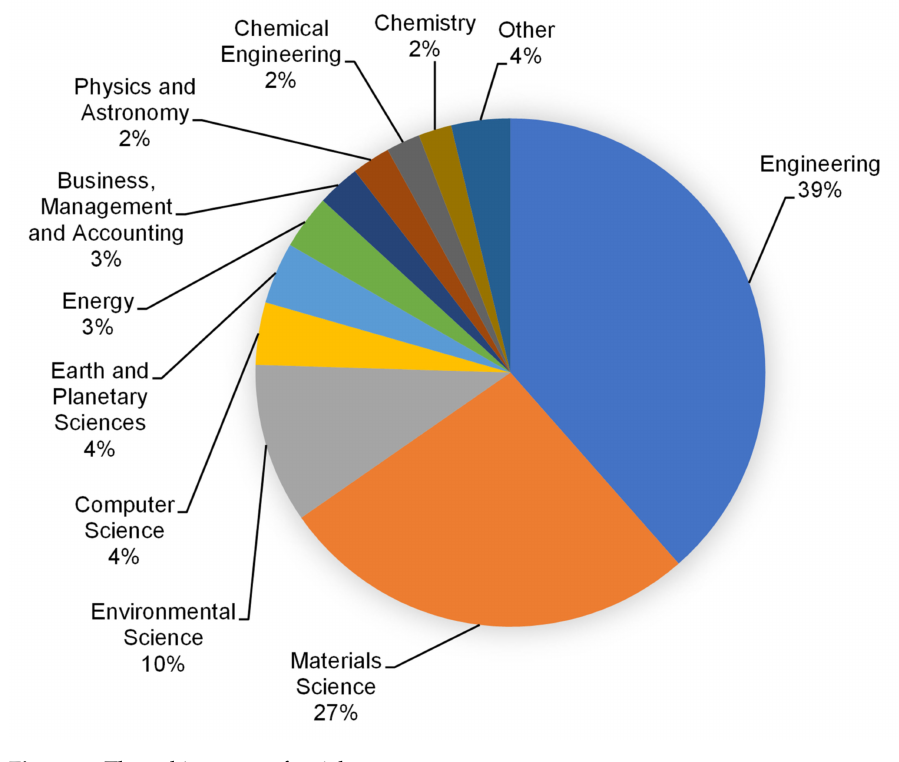
Figure 3. The subject area of articles.